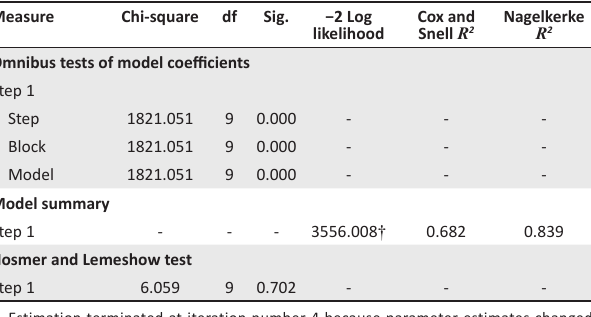
TABLE 8a: Logit model.